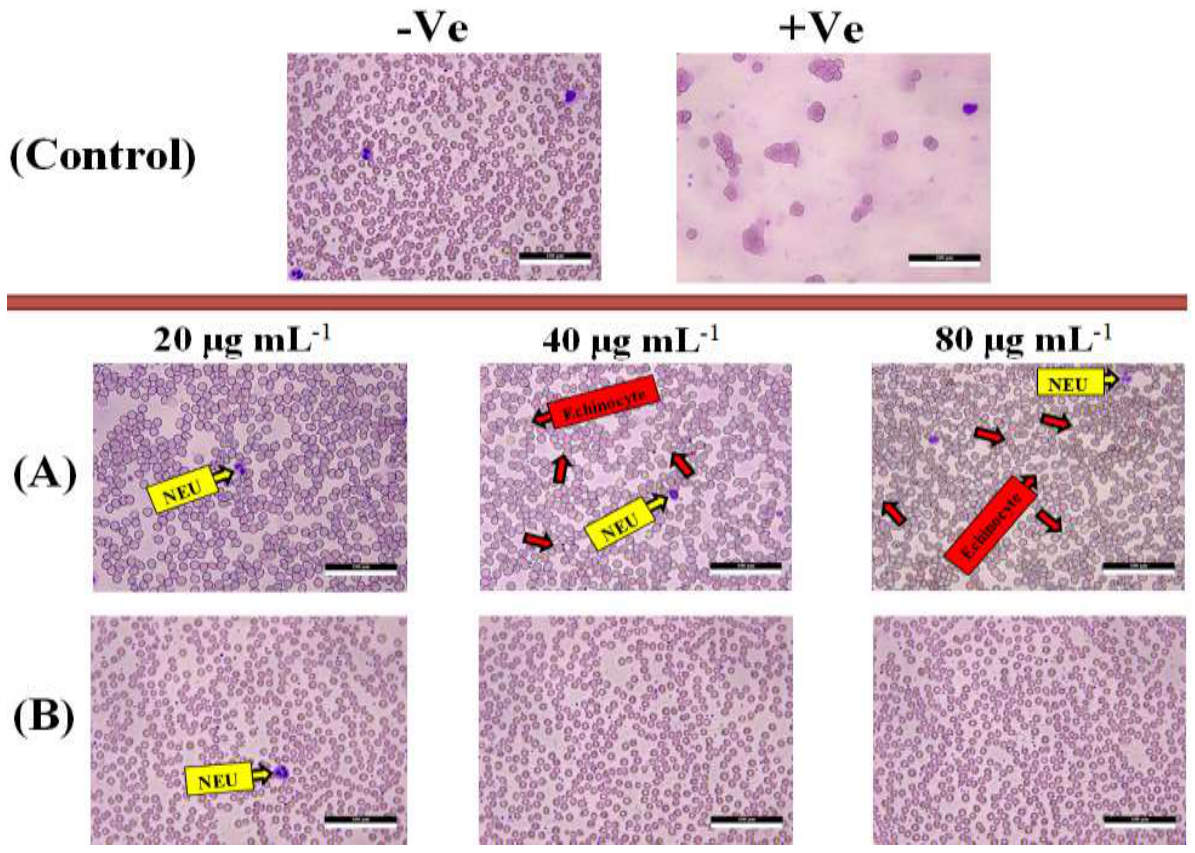
Figure 6: Light microscopic images showing the hemolytic toxicity: (A) : Normal or natural RES (B) : RES-loaded poloxamer 407 at concentrations (20, 40 and 80 µg mL -1 ) along with the positive and negative controls. * the yellow arrow is Neutrophil, while red arrow is the abnormal cells (Echinocytes) due to the effect of pure RES on their walls. Scale bar: 100µm. –Ve and + Ve : negative and positive control,